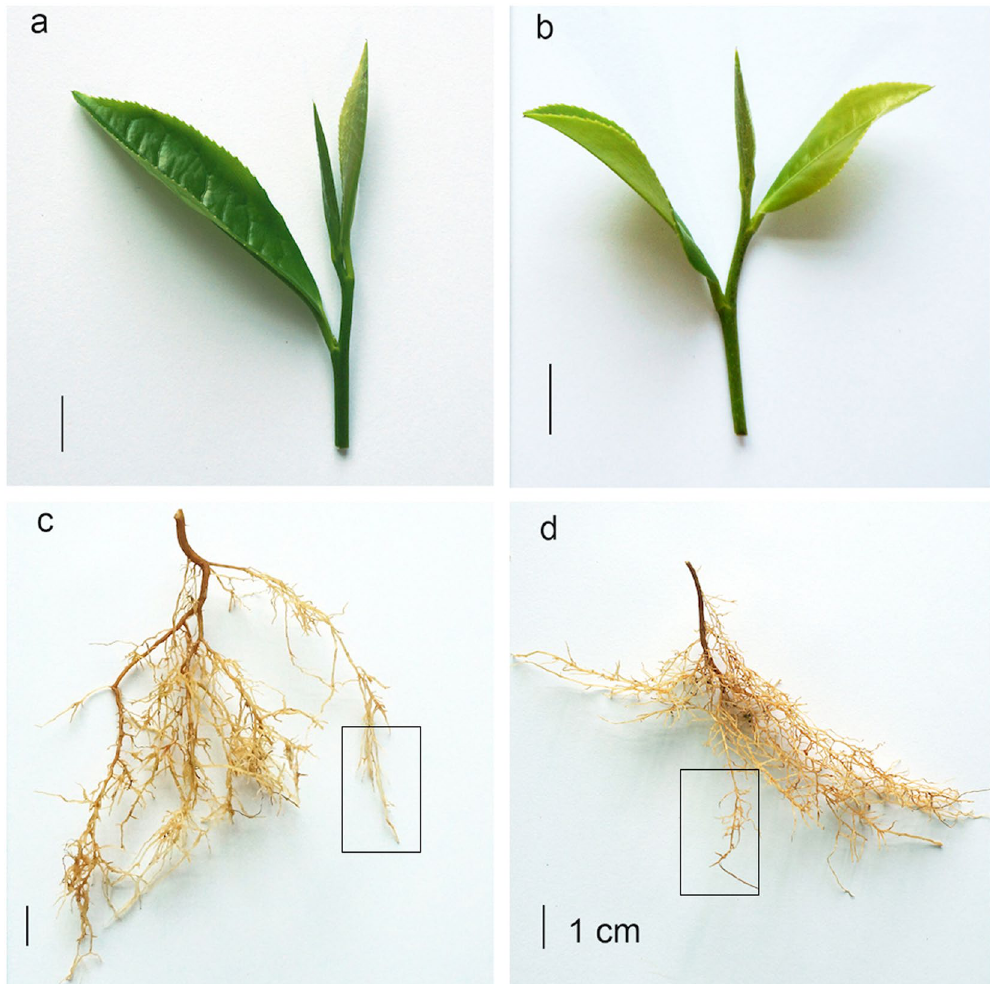
Figure 1. C . sinensis tea leaf and root samples. Images show the used tea samples without ammonium treatment. ( a , b ) are the representative leaves of the C . sinensis varieties HJ and FD. Only the buds and leaves were used in the study. ( c , d ) are the representative roots of the C . sinensis varieties HJ and FD. The boxed roots represent the types of roots used for analysis.